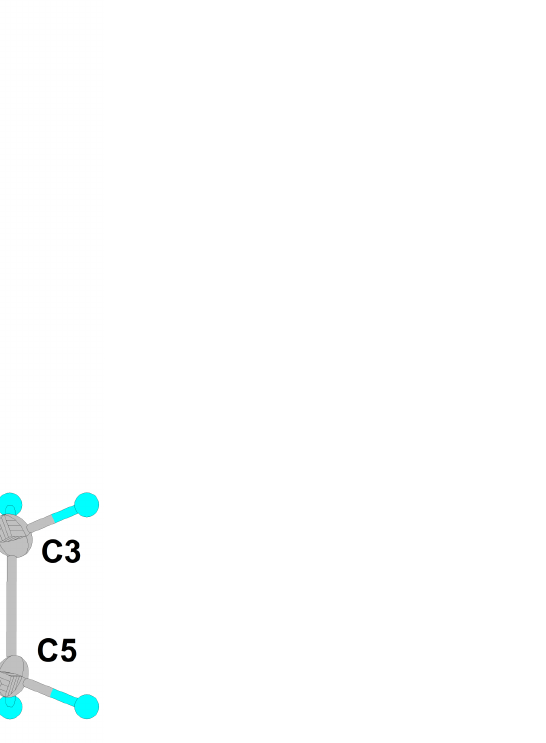
Figure 7. The molecular structure of 5 . Thermal ellipsoids are drawn at the 50% probability level. Symmetry operation: x, ½ − y, z (i).